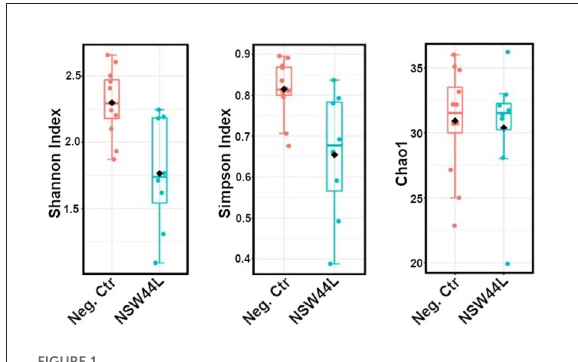
FIGURE1 Alpha-diversity plots showed the C. hepaticus NSW44L challenged group has significantly lower Shannon and Simpson alpha diversity [ p = 0.009 and 0.0233, respectively, (left and middle panels) ] compared to the control group. No significant difference was found in the Chao1 richness index (right panel) .